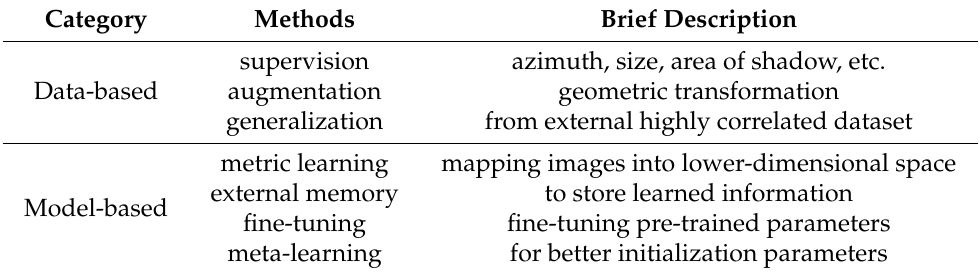
Table 1. Existing methods of few-shot